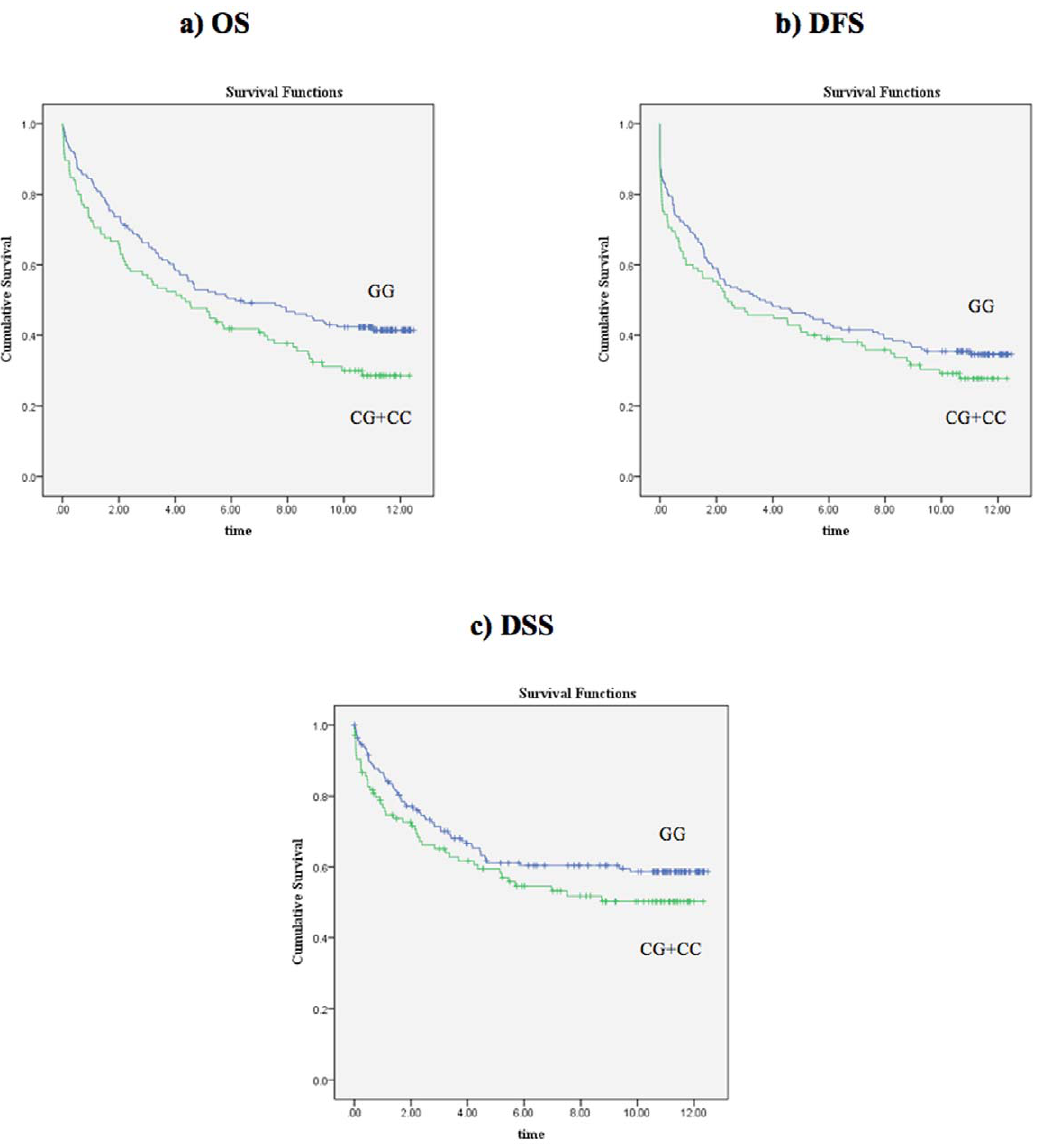
Figure 1. Kaplan-Meier survival curves for patients grouped based on the SLC6A4 -rs12150214 genotype data. a) OS (p=0.030, log- rank test), b) DFS (p=0.225, log-rank test), and c) DSS (p=0.159, log-rank test). Time is shown in years.